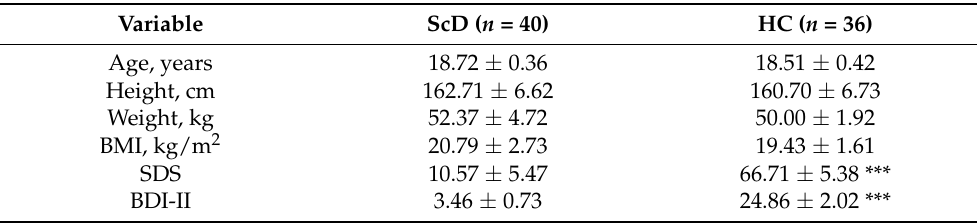
Table 1. Demographic information of participants (Mean ±